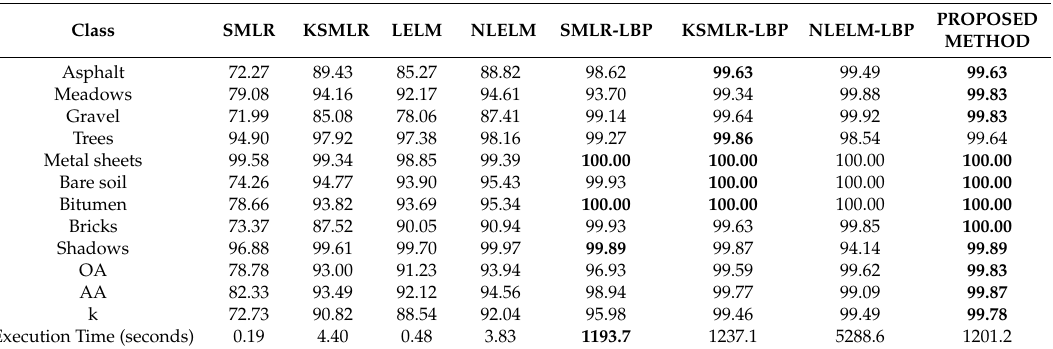
Table 3. Pavia University: overall, average, and individual class accuracy (in percent) and k statistic of different classification methods with 10% training samples. The best accuracy in each row is shown in bold.